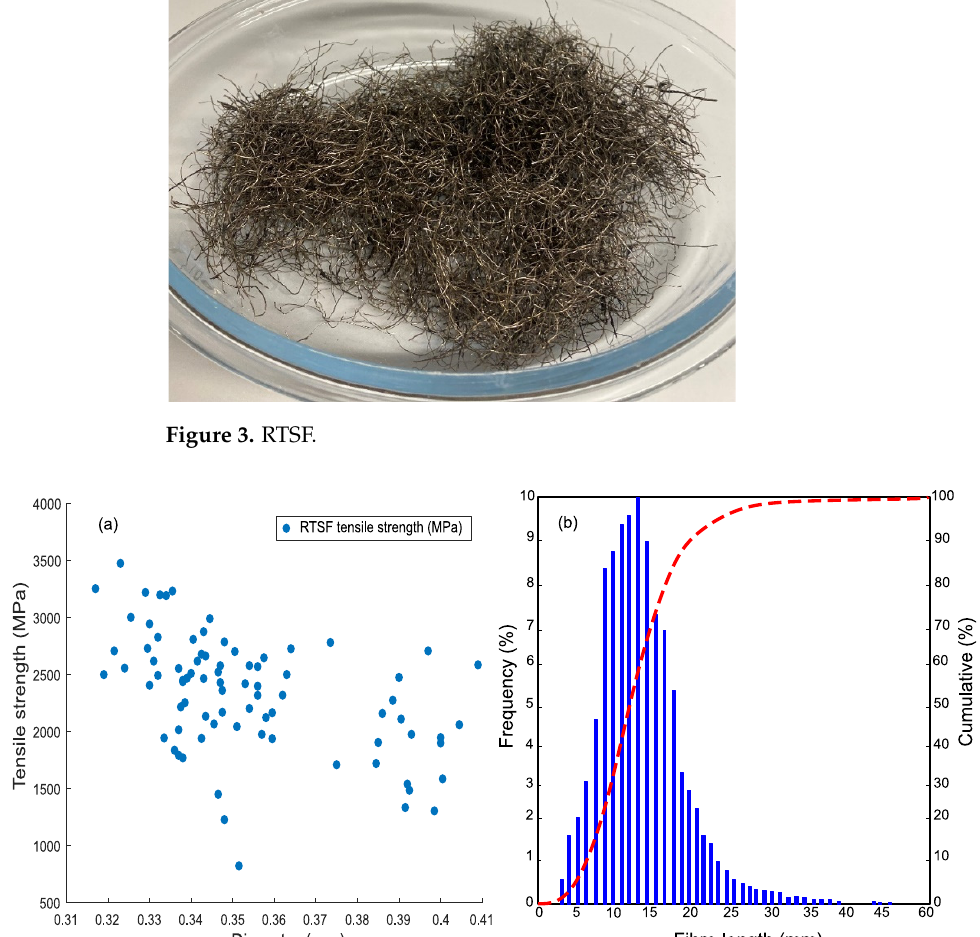
Figure 4. ( a ) Tensile strength; and ( b ) RTSF length distributions [64].